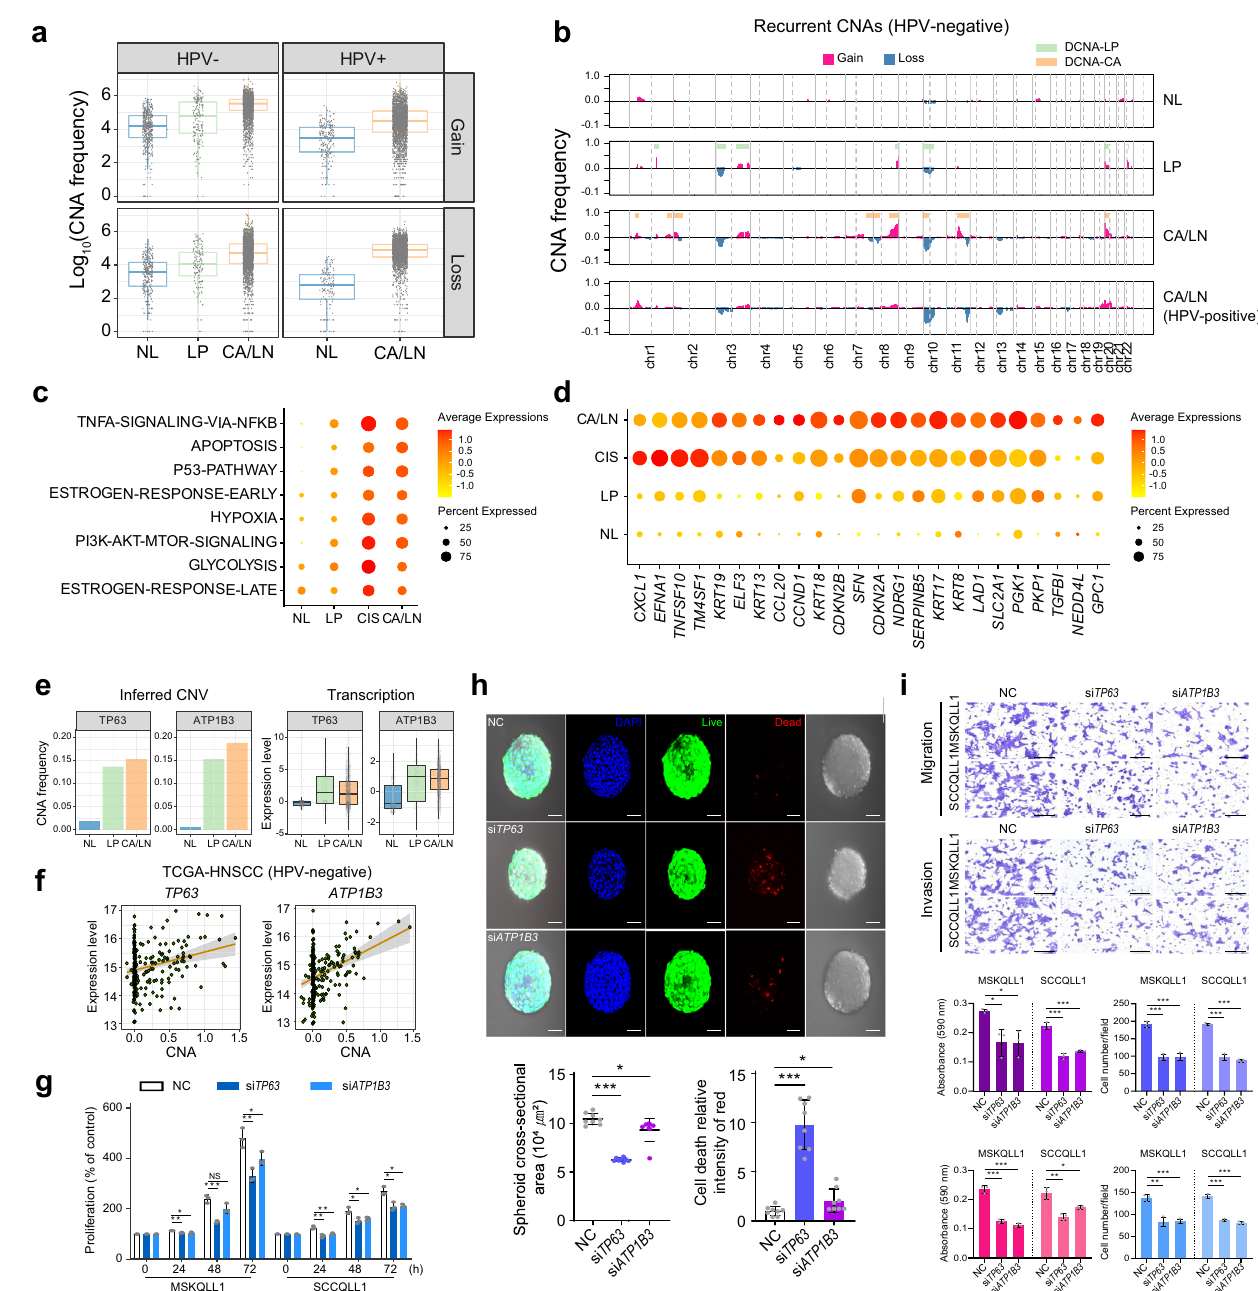
Fig. 2 | DNA copy number-dependent deregulation of TP63 and ATP1B3 pro- motes HNSCC progression. a For each tissue type, log-scaled frequencies of the CNAgains ( top ) and losses ( bottom ) in the HPV-negative and HPV-positive samples are shown. b CNA frequencies are shown in chromosomal order for each HPV- negativetissuetype. c , d DotplotsshowthedifferentialexpressionoftheHallmark gene sets ( c ) and genes ( d ) in the epithelial cells across the tissue types of NL, LP, CIS, and CA/LN tissues. e Frequencies of the CNAs ( left ) and the expression levels ( right ) of TP63 and ATP1B3 genes in HPV-negative patients are shown. f DNA copy number-correlatedtranscriptionalexpressionof TP63 and ATP1B3 areshowninthe HPV-negative TCGA-HNSCC patients ( n =240). g The MSKQLL1 and SCCQLL1 cells are treated with the non-target control (NC), si TP63 , or si ATP1B3 , and their viabil- ities are shown at indicated times. h FaDu cells are transfected with NC, si TP63 , or